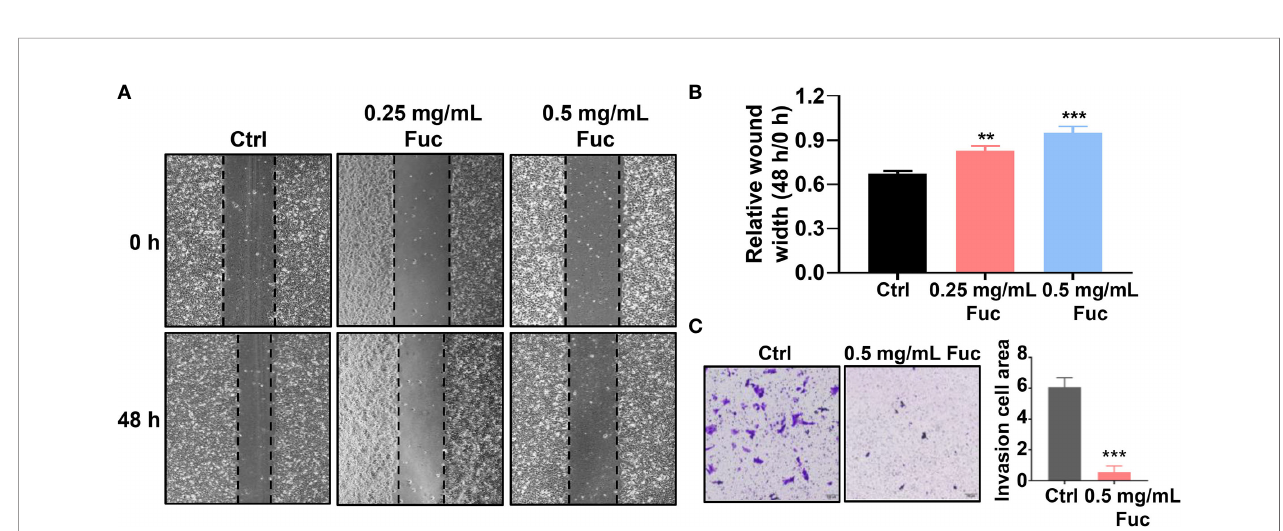
FIGURE 3 | Fucoidan inhibits motility and invasion of hepatocellular carcinoma cells. (A, B) Wound healing results of MHCC-97H treated with saline (Ctrl), 0.25 and 0.5 mg/mL Fuc. ** means P < 0.01, *** means P < 0.001. (C) Transwell results of MHCC-97H treated with saline (Ctrl) and 0.5 mg/mL Fuc. *** means P <